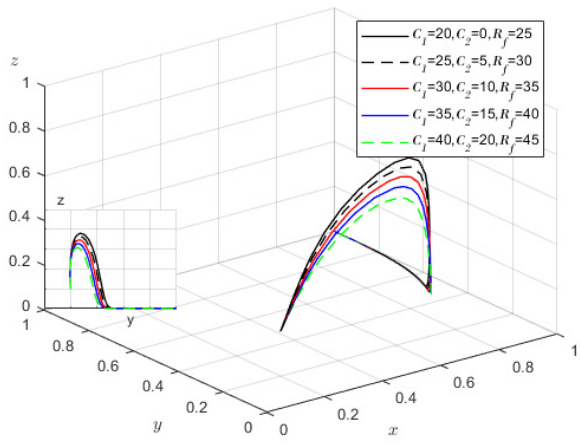
Figure 8. The impact of market regulation.